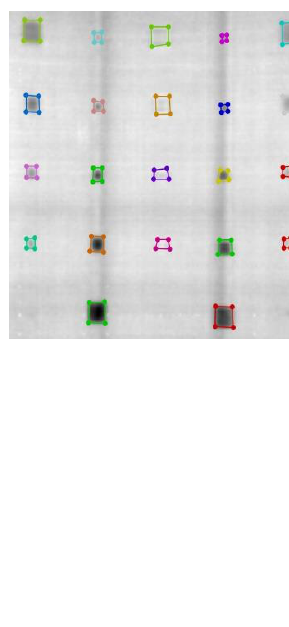
8 of 22 Figure 6. Scheme of preprocessing stage. 4. Dataset and Features The experimental samples and databases are acquired from two different materials: plexiglass and CFRP (carbon fiber-reinforced polymer). Two independent experimental groups were set up based on these materials. The whole database consisted of 500 images (446 × 446 pixels each). Six sub datasets were formed respectively from the two materials: plexiglass (A; B; E) and CFRP (C; D; F), which collected specific instants (5 s; 15 s; 25 s…) from 20 different thermal sequences during the temperature evolution in pulse thermog- raphy for both regarding training and validation data in order to avoid redundant infor- mation. Based on the two types of images, 200 synthetic thermal images were generated with COMSOL, and 200 raw thermal images were collected from pulsed thermography exper- iments. Four groups of training databases were created based on the images we collected in the previous steps: 1. Database A, C: (Original database) 100 raw thermal images from thermal sequences with corresponding time; 2.